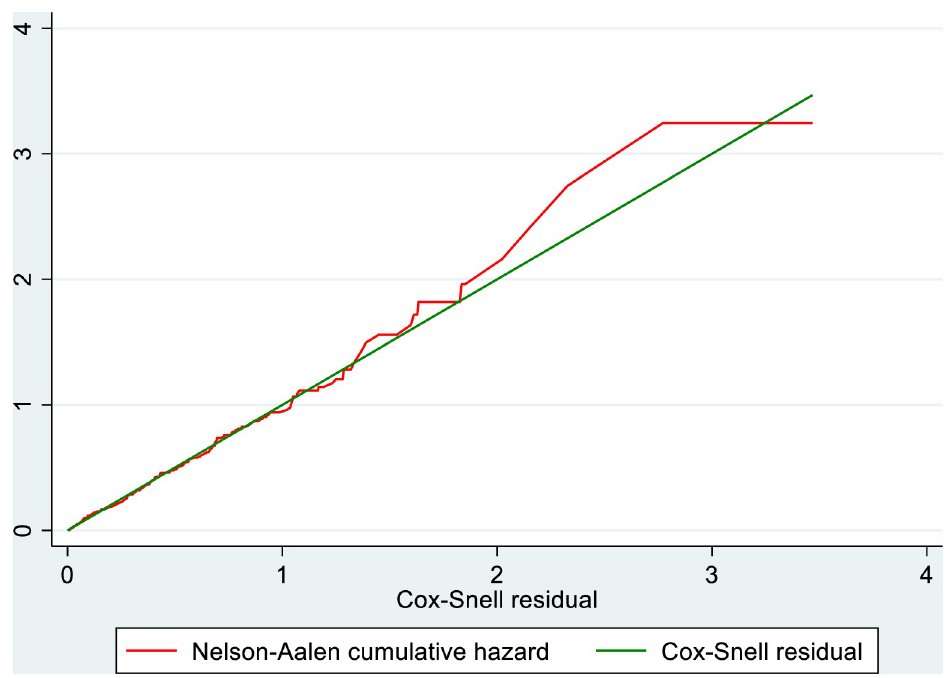
Fig 2. Plot of Nelsen-Allen cumulative hazard function against Cox-Snell residual.